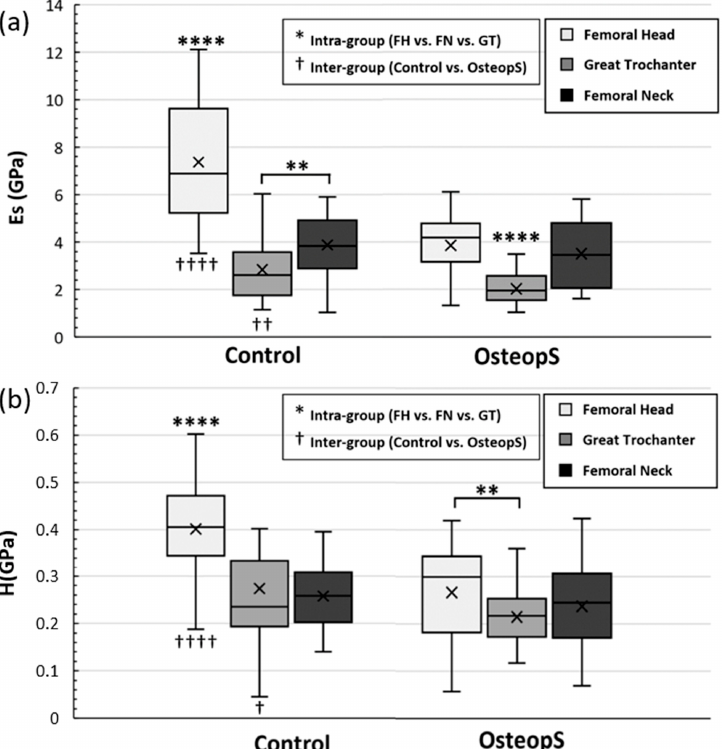
Figure 6. Whisker plot of ( a ) elastic modulus (Es) and ( b ) hardness (H) obtained using microindentation on trabecular bone specimens. ( a ) Representation of intra-group variation of elastic modulus. On the left the differences between the three ROIs in the control subject are presented, and on the right are the differences for the osteoporotic subject. ( b ) Representation of intra-group variation of hardness. On the left are presented the differences between the three ROIs in the control subject and on the right the differences for the osteoporotic subject. * represents the variability between different region of the same group (intra-group), ** p < 0.01 and **** p < 0.0001. † represents the variability between same regions of different group (inter-group) † p < 0.05, †† p < 0.01 and †††† p <